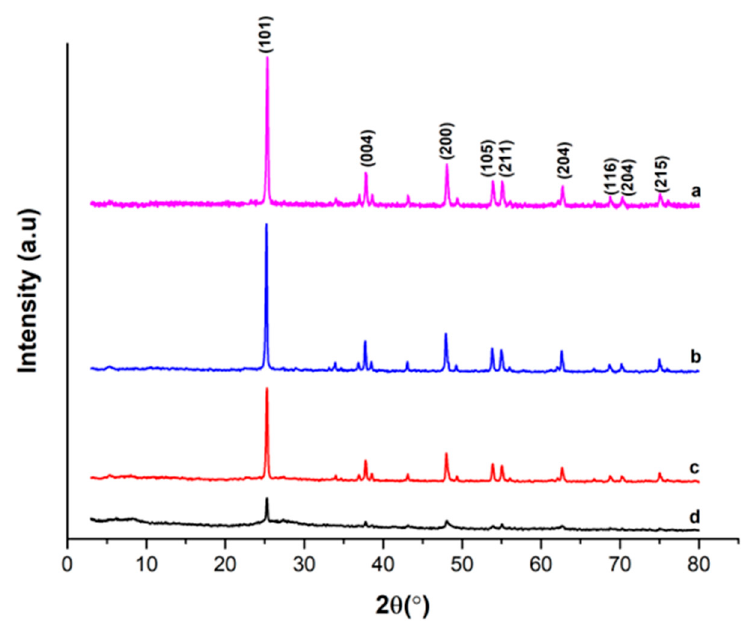
Figure 2. The XRD patterns of ( a ) TiO 2 , ( b ) TiO 2 –N (5), ( c ) TiO 2 –N (10) and ( d ) TiO 2 –N (15) .